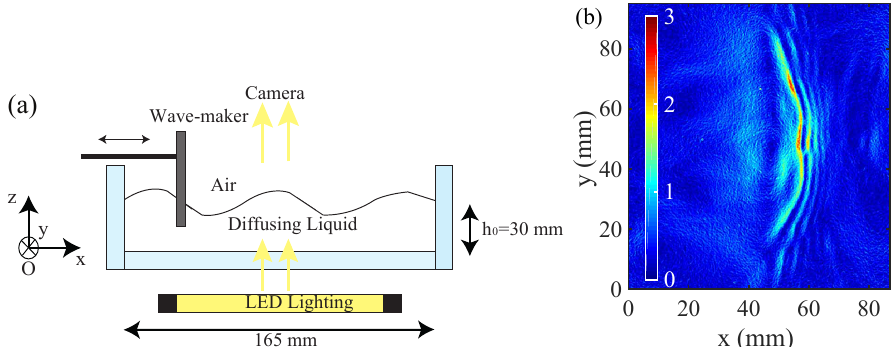
Figure 15. ( a ) Experimental setup. Surface waves are produced by the horizontal motion of a rectangular paddle, and the free surface is measured in space and time using diffusing light photography (DLP). ( b ) Snapshot of the spatial gradient of wave elevation ||∇ h ( x , y ) || for at t = 1.51s. The wave- maker is parallel to the y -axis and located at x = − 12mm. Measurement parameters: σ h = 3.6mm (standard deviation of the free-surface deformation) and σ s = 0.34 (standard deviation of the free- surface steepness ||∇ η || ) . Colorscale is dimensionless. A train of capillary waves is visible on the forward front of the large carrier wave. (Reprinted with permission from [71] Copyright 2022 Cambridge University Press).